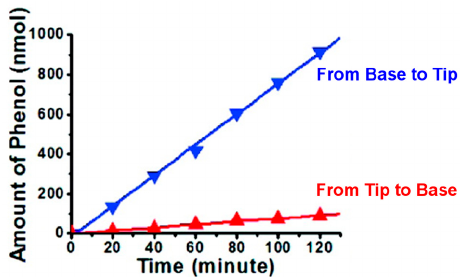
Figure 9. Schematic illustration of the permeation cell used to measure the flux of phenol (electroosmotic flow (EOF)) from the feed solution through the pyramidal pore mica membrane and to the receiver solution. The mica membrane was mounted with the base facing the feed solution to measure base-to-tip flux, or with the base facing the receiver solution to measure tip-to-base flux. Dimensions are not to scale.